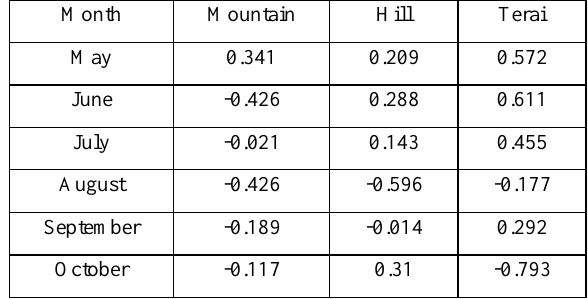
Table 1. Correlation coefficient between NDVI and rainfall (r(NDVI, Rainfall)) across different ecological regions during